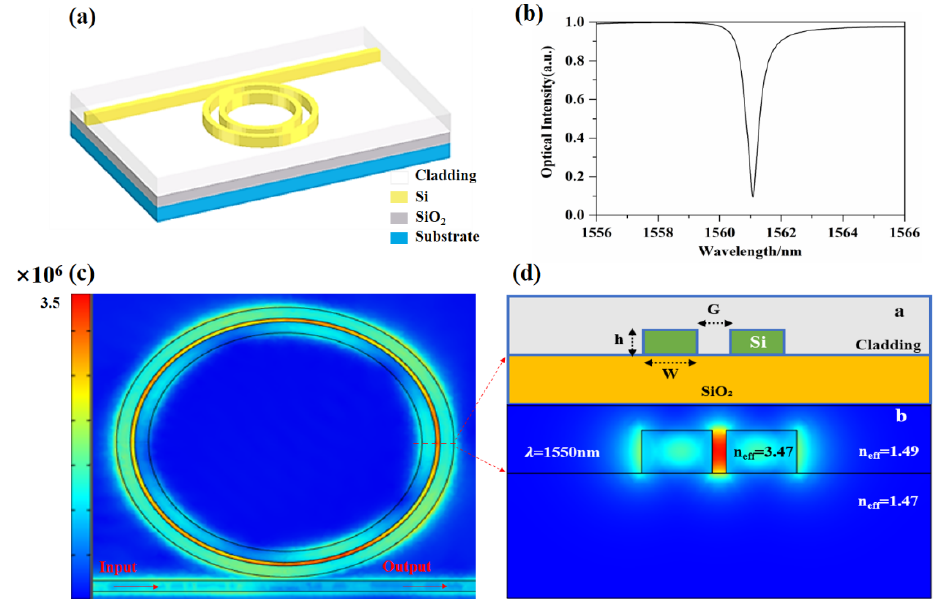
Figure 1. ( a ) Schematic diagram of the structure, ( b ) transmission line of the microring resonator (coupling gap is 100 nm), ( c ) resonant state mode distribution diagram of the resonator cavity, and ( d ) cross-sectional structure diagram and mode distribution diagram.